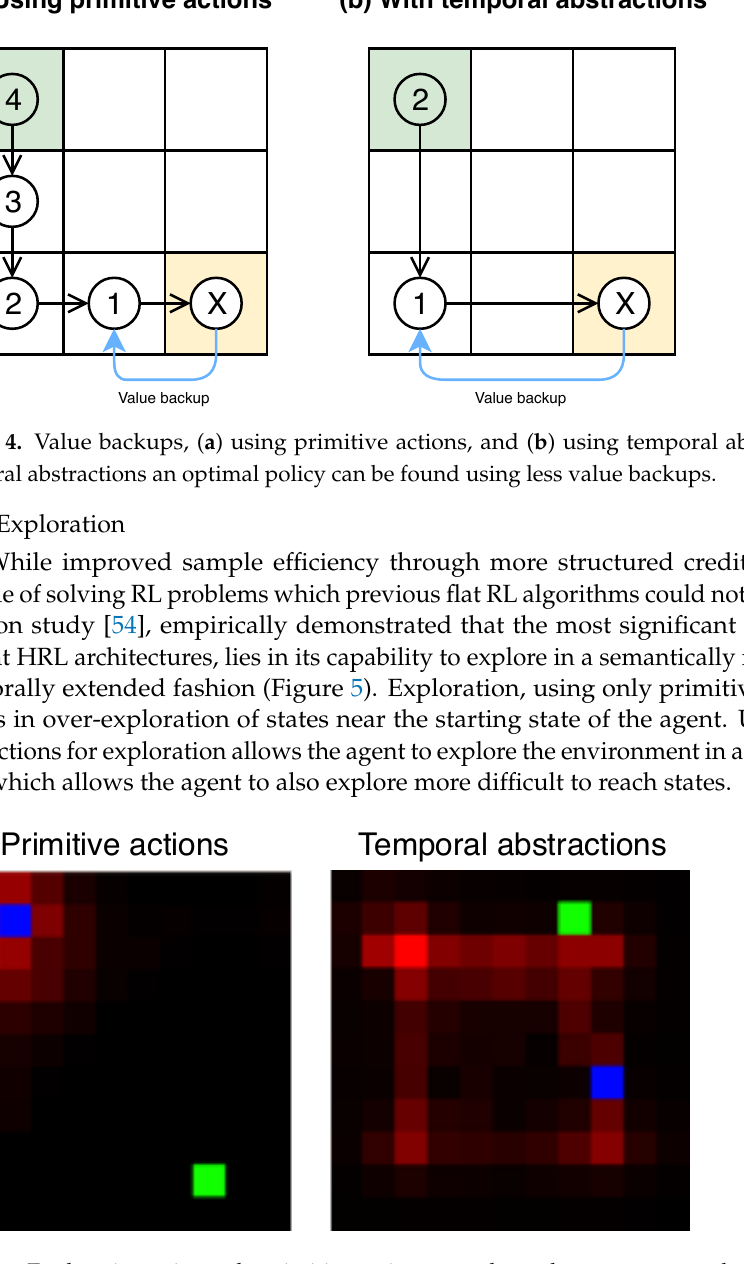
Figure 5. Exploration using only primitive actions, mostly explores states near the starting position of the agent (state visitation counts are represented using a red gradient). Temporal abstractions can help the agent to explore more distant